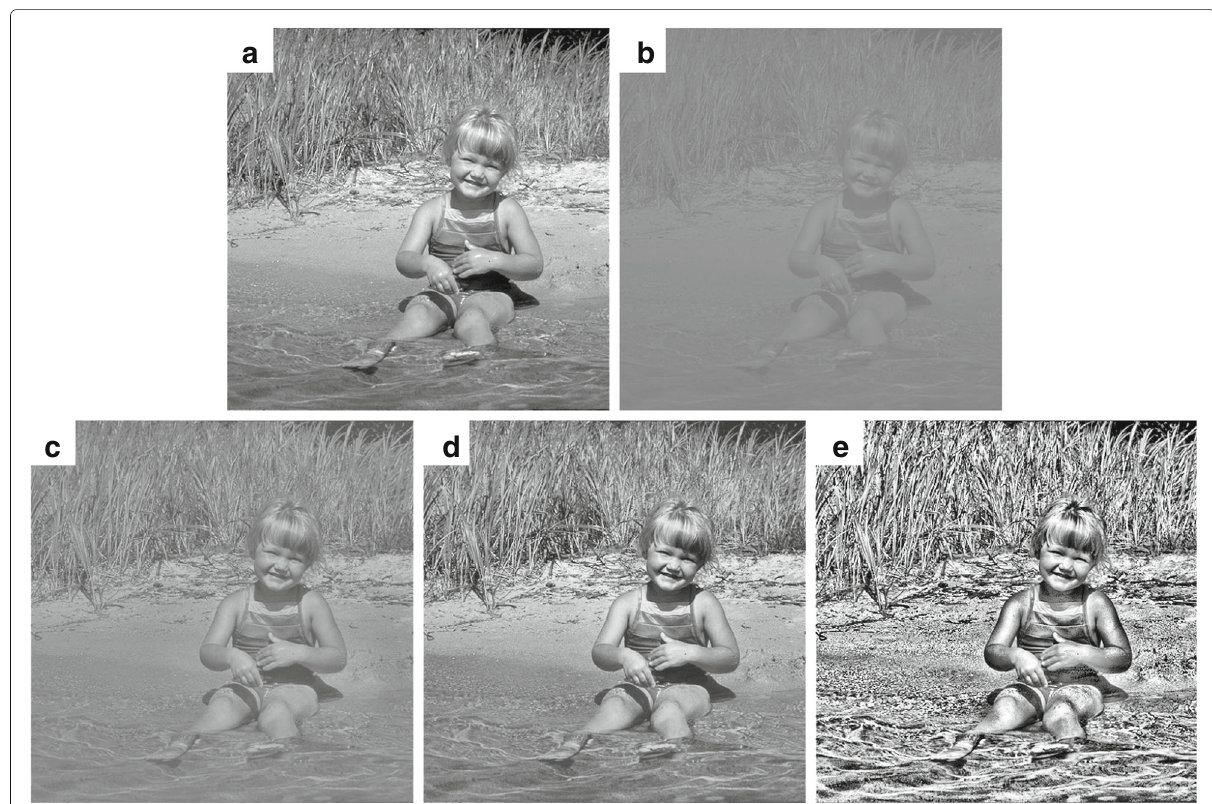
Fig. 6 Automatic labeling process to find best CLAHE hyperparameter pair. Original image ( a ). distorted image ( b ). CLAHE with inacurrate hyperparameters: CL = 0.01 and NT = [8,8] ( c ). CLAHE with ideal hyperparameters: CL = 0.025 and NT = [4,4] ( d ). CLAHE with inacurrate hyperparameters: CL = 0.468 and NT = [16,16] ( e